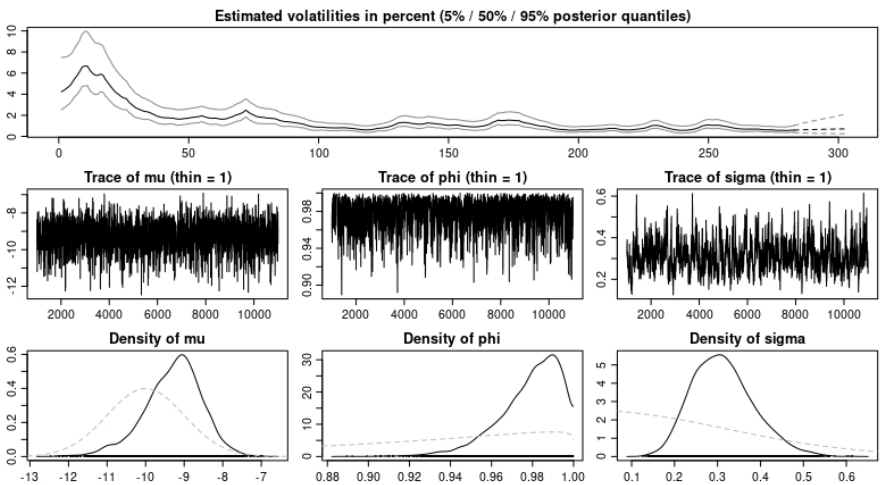
Figure 4. Graph showing estimated volatility for the Dow Jones.